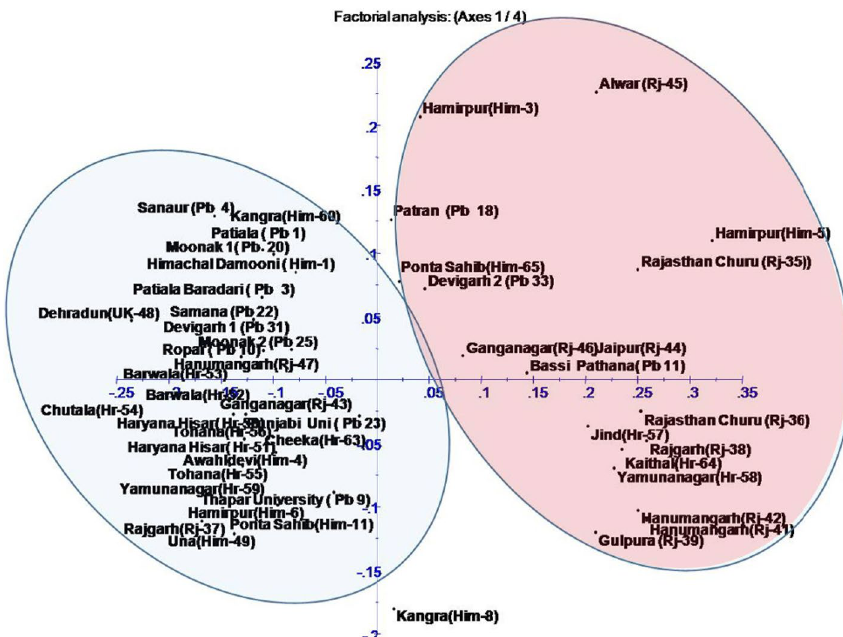
Fig. 3 Principal coordinates analysis based on Eigenvalues calculated from 23 SSR markers. The 48 accessions were assigned into two groups